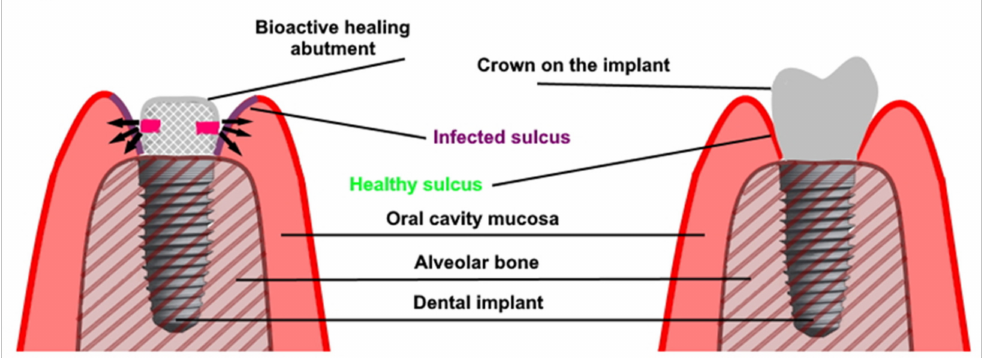
Figure 2. Bioactive healing abutment method of action: ( left ) treatment with bioactive healing abutment and ( right ) implant restoration after